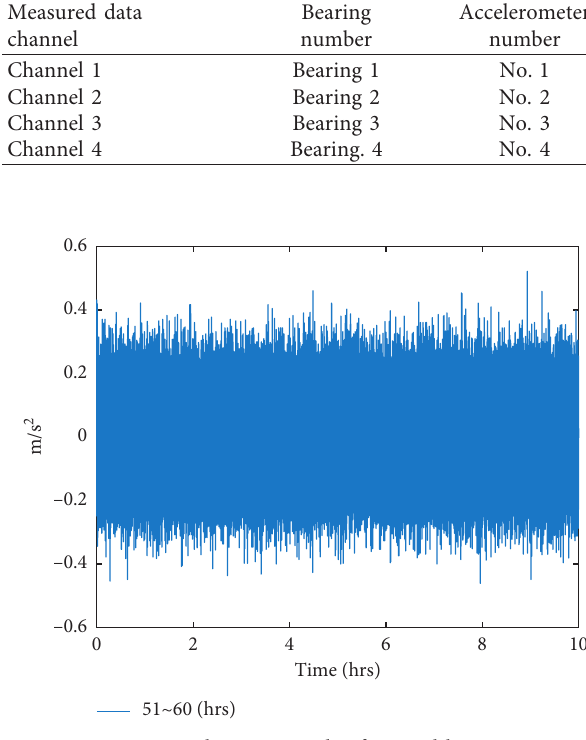
Figure 7: Vibration signals of normal bearing.